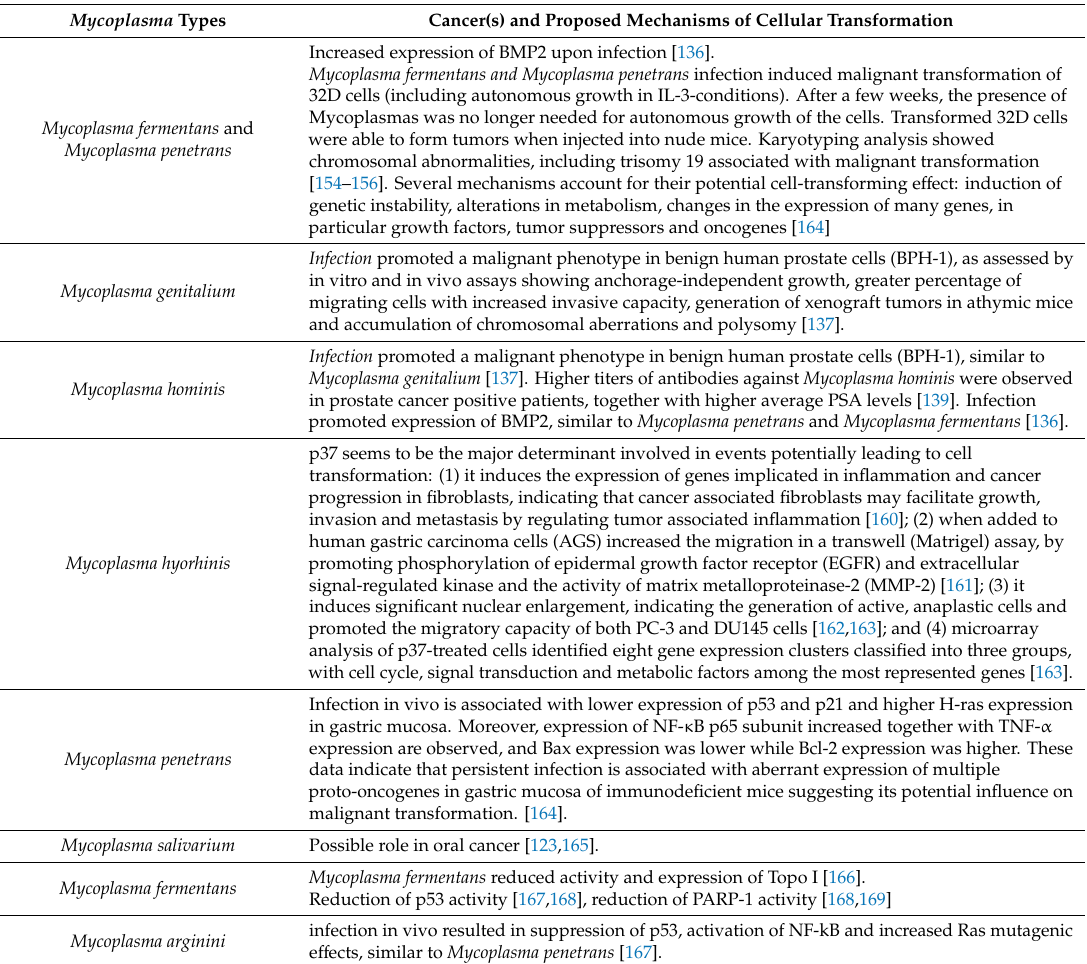
Table 2. Association between several species of Mycoplasmas, cancer(s), and proposed mechanisms of cellular